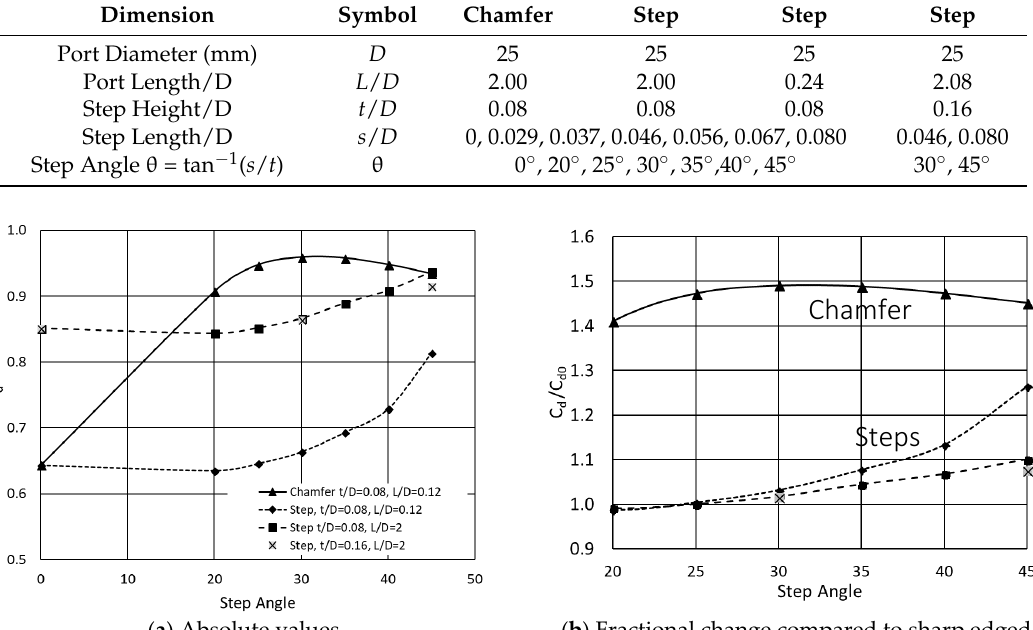
( b ) Fractional change compared to sharp edged Figure 12. Stepped inlet and chamfered inlet comparison for a range of step/chamfer angles.